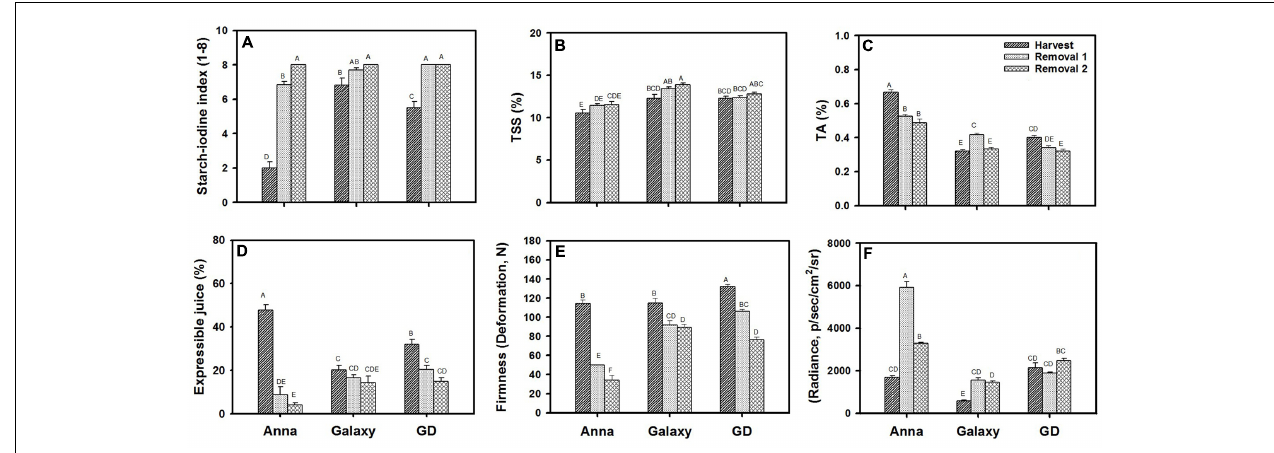
FIGURE 1 | Quality parameters of “Anna,” “Galaxy,” and “GD” at harvest and following postharvest storage of 1 month (removal 1, R1) and 2 months (removal 2, R2). Fruit were stored at 0 ◦ C and analyzed following transferring to 20 ◦ C for 2 days. (A) Starch content, determined by starch–iodine index, (B) total soluble solids (TSS), (C) titratable acidity (TA), (D) expressible juice, and (E) firmness determined by 5% deformation, (F) lipid oxidation determined by autoluminescence and expressed in radiance (p/s/cm 2 /sr). Details of analysis are described in materials and methods. Parameters (A–E) represent the mean of 10 fruit, (F) with 6 fruit, and vertical bars indicate ± SE. Significance analysis was performed by comparing all cultivars and their stages collectively, using Tukey’s HSD pairwise comparison tests at p ≤ 0.05. Unlike letters represent significantly different groups.